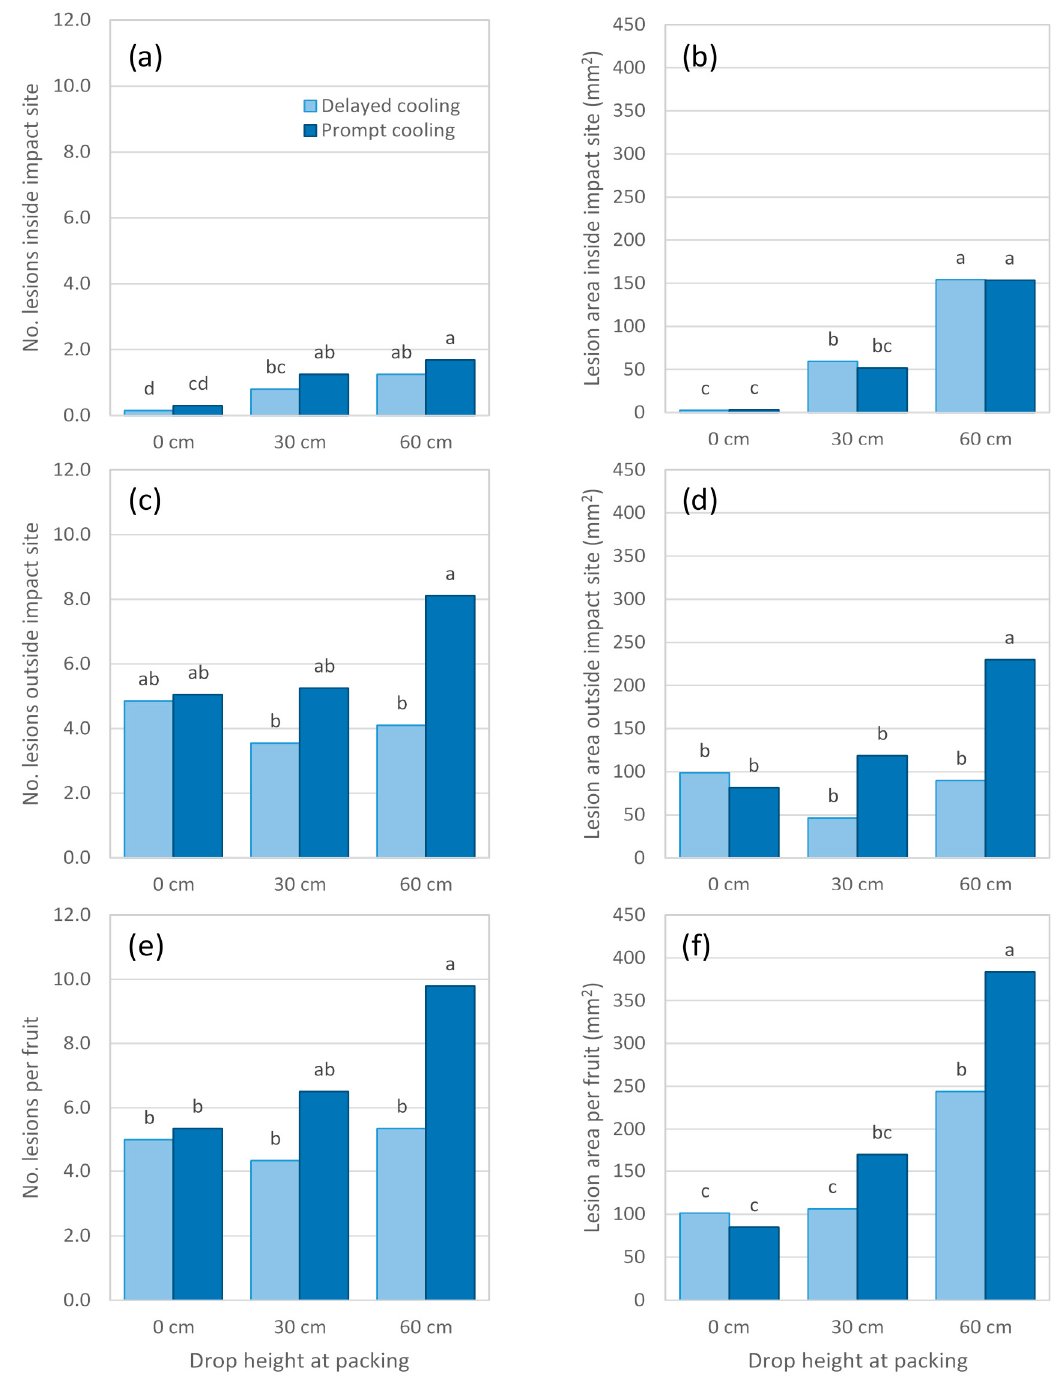
Figure 8. Lesion number ( a , c , e ) and lesion area ( b , d , f ) inside the impact site ( a , b ), outside the impact site ( c , d ) and for the whole fruit ( e , f ) in ‘Hass’ avocado fruit from Experiment 7 at 1 d after reaching firm-ripe stage. Fruit were harvested on 17 or 20 August 2018 and subjected to drop heights of 0, 30 or 60 cm on 21 August 2018. Fruit from the first harvest were held at ambient conditions for 48 h followed by 48 h at 12 °C (delayed cooling). Fruit from the second harvest were cooled to 12 °C on the day of harvest (prompt cooling). Means that do not share a letter are significantly different ( p < 0.05) according to Fisher’s LSD test.